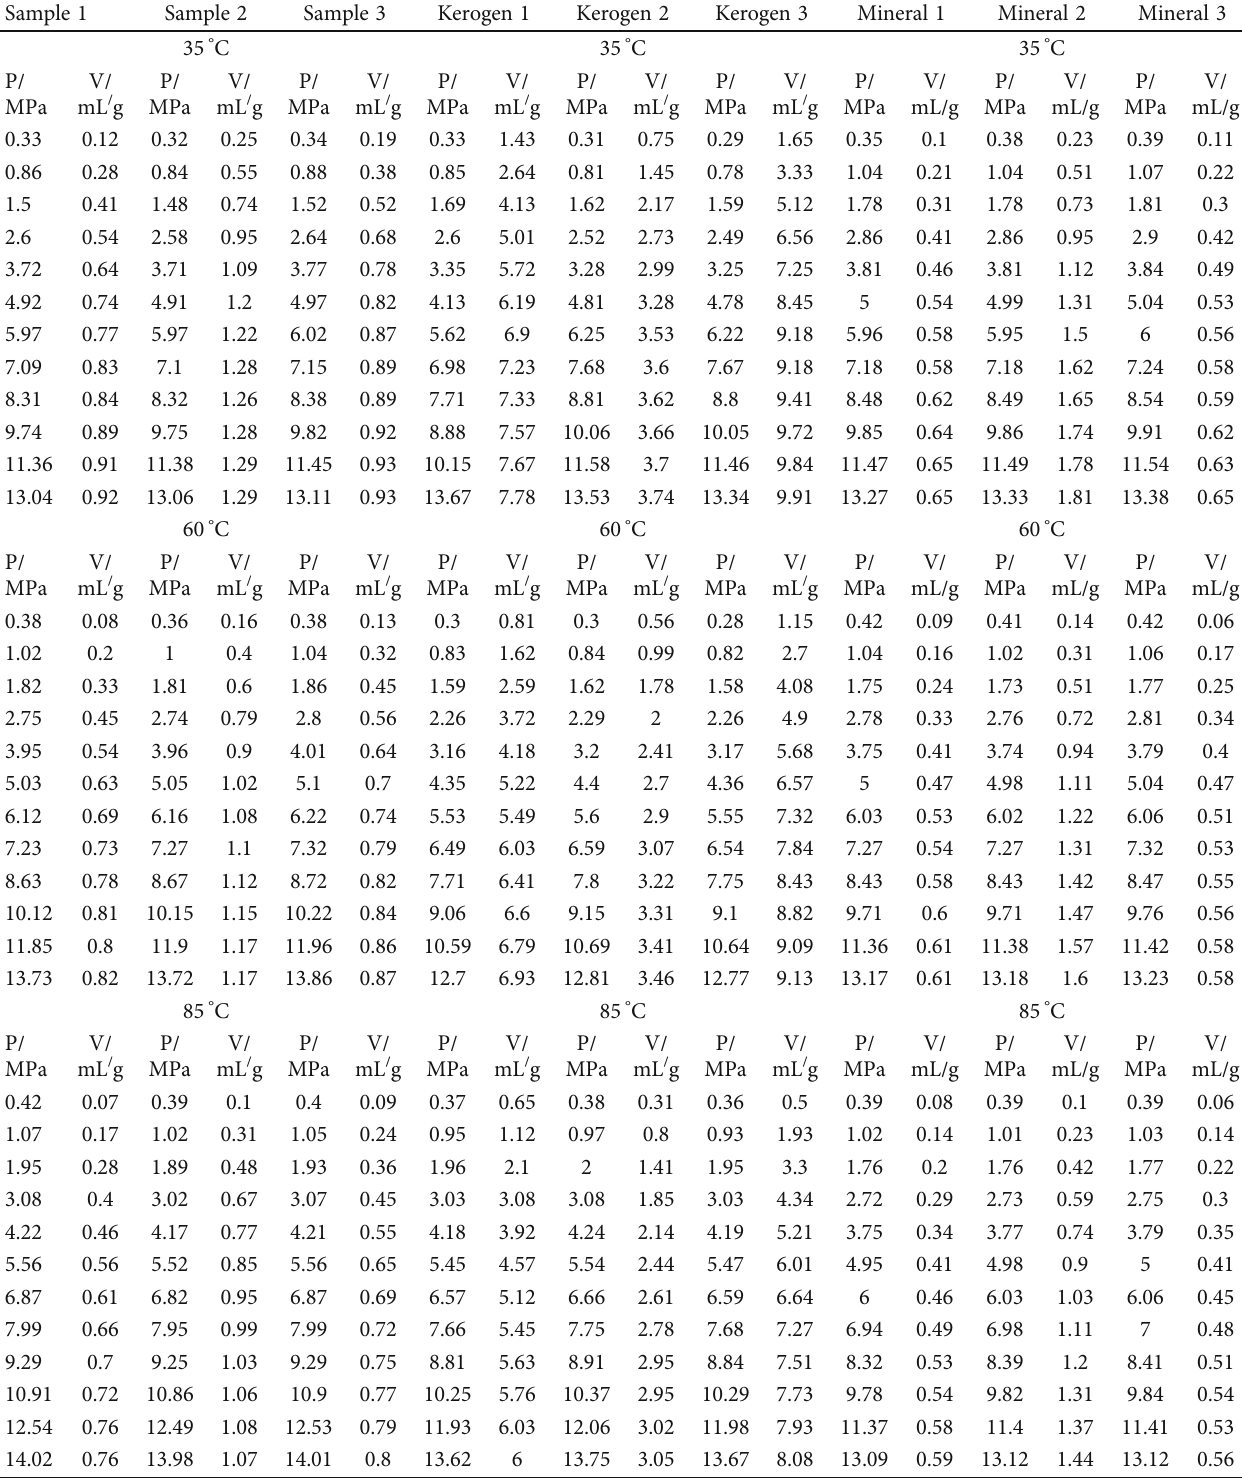
Table 3: Isothermal adsorption